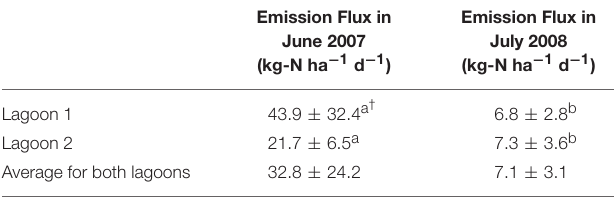
TABLE 2 | NH 3 emission fluxes from the two